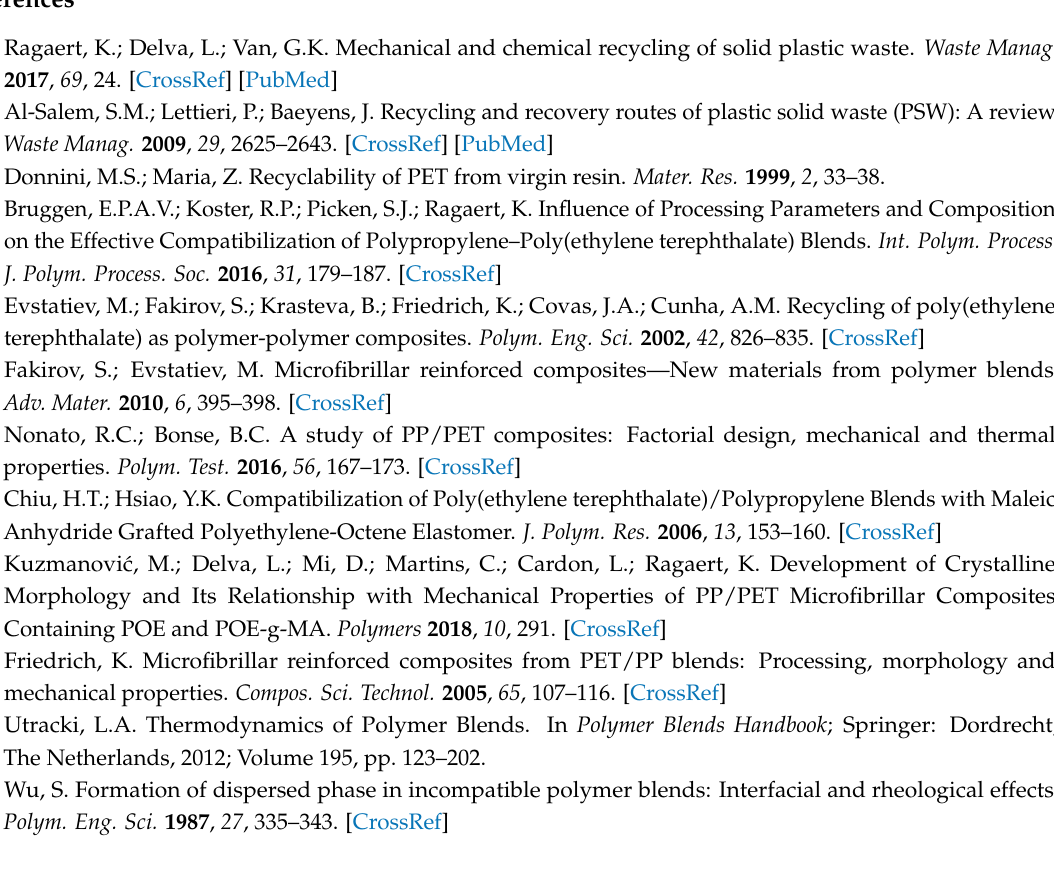
s1. Figure S1: Mechanical properties of samples with various content of POE-g-MA, Figure S2: PLM photos of different